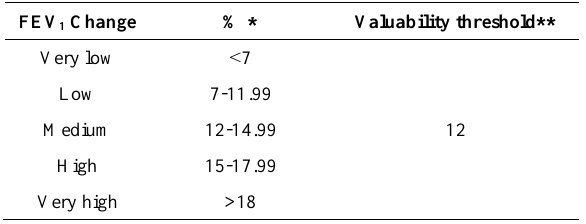
Table 4. FEV 1 Change proposed ranking for health tourism purposes